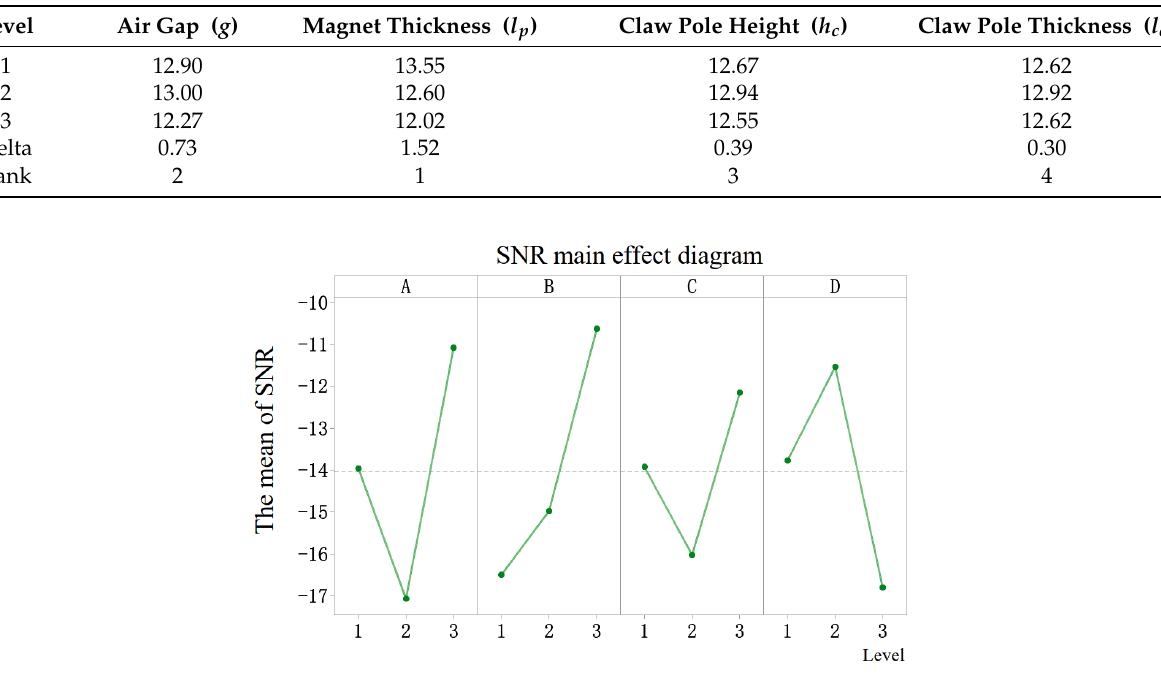
Figure 4. SNR diagram of each factor’s response to detent